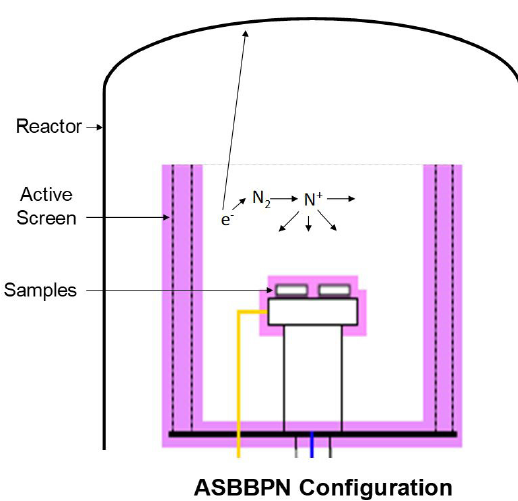
Figure 9. ASBBPN nitriding